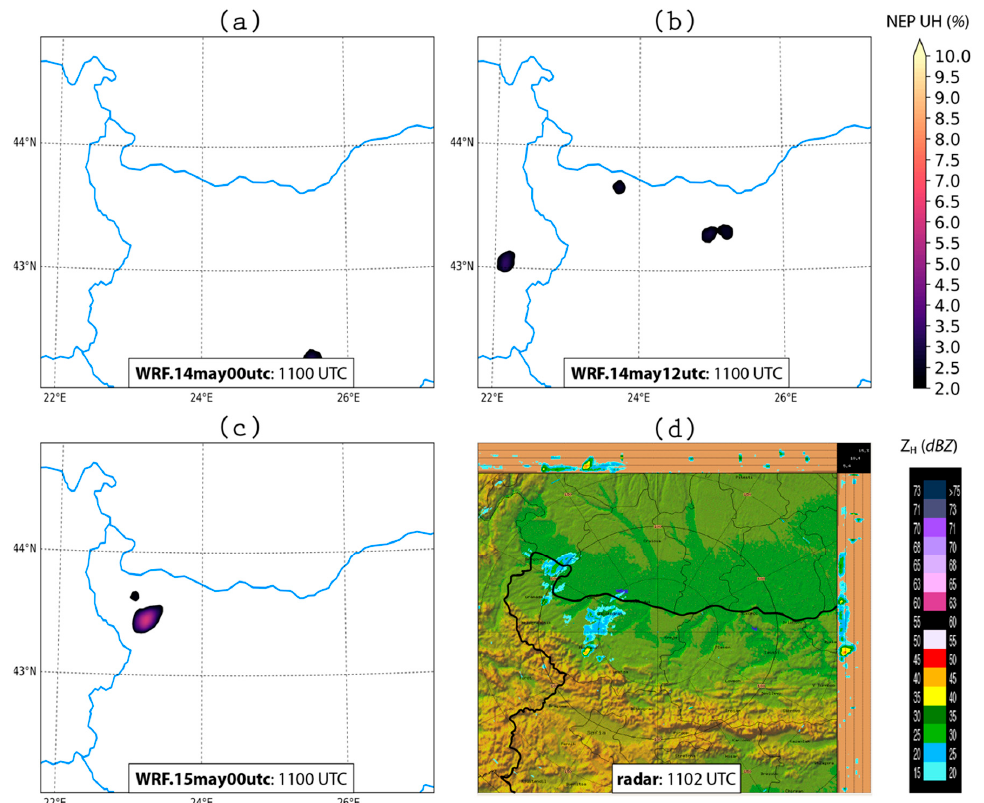
Figure 11. Supercell initialization in the WRF ensemble forecasts. Panels ( a )–( c ) display neighborhood ensemble probabilities (NEP) of hourly-maximum 2–5 km updraft helicity (UH) exceeding 100 m 2 s − 2 for WRF.14may00utc, WRF.14may12utc and WRF.15may00utc at 11:00 UTC, respectively, while panel ( d ) shows the composite reflectivity at 11:02 UTC. Country borders are contoured in light blue for the WRF forecasts and black for the composite radar image.